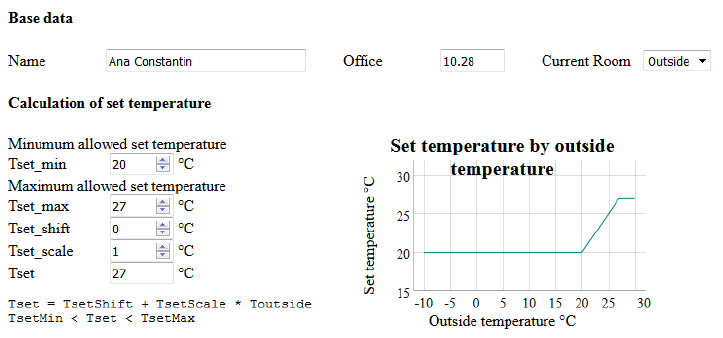
Figure 4. Screen shot of the user GUI detailing the calculation of set temperature as a function of outside